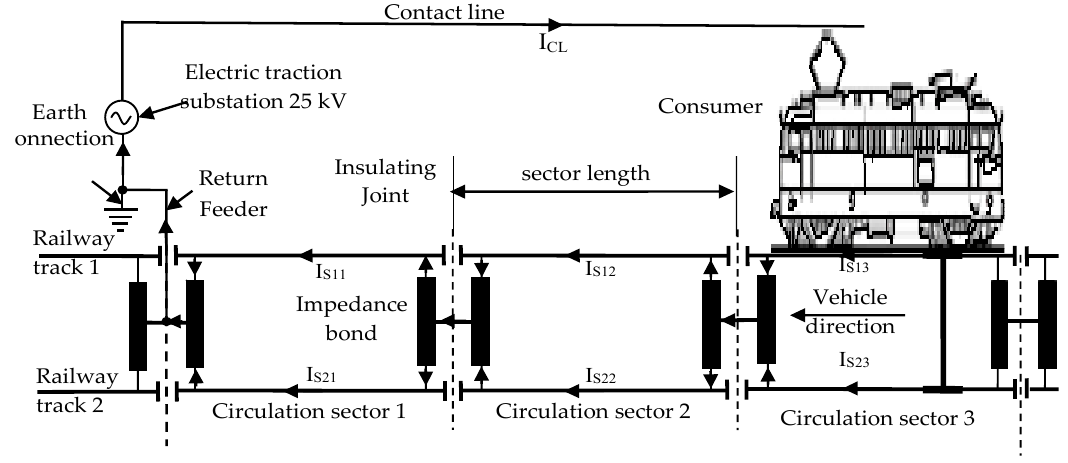
Figure 1. Traction current return circuit from the power supply system of railway infrastructure.